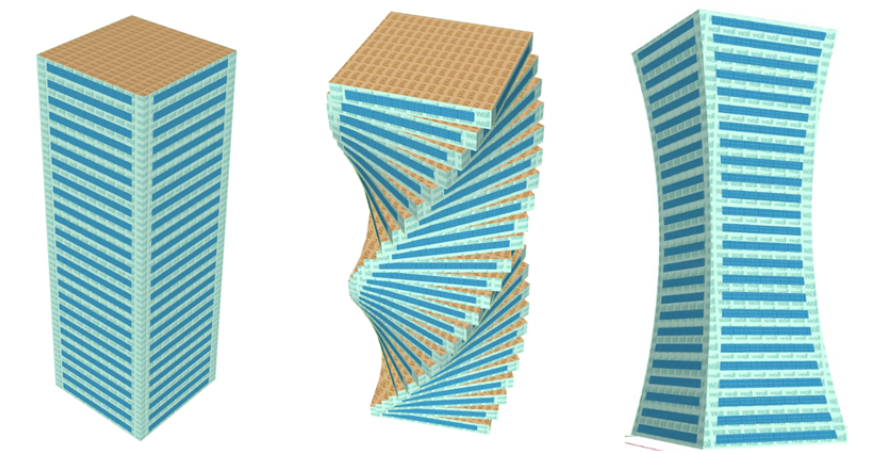
Fig. 1. The selected models (extruder, twister, rotor)